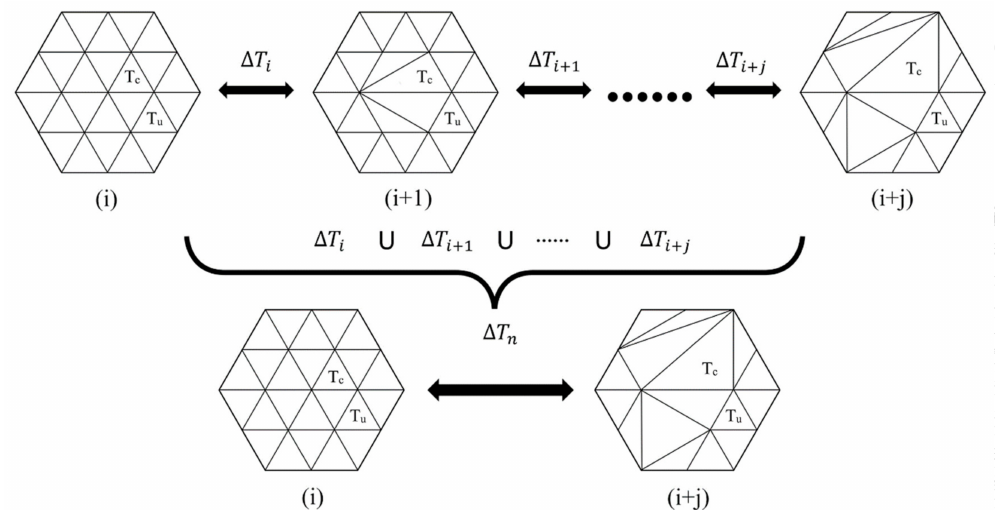
Figure 7. Sketch of the incremental information compression. From scale i to scale i + j , each related triangle needs to change, at most, j times. By compressing ∆ T i ~ ∆ T i + j into ∆ T n , the correlation triangles are only stored and changed once, so as to reduce data redundancy and increase the smoothness of scale